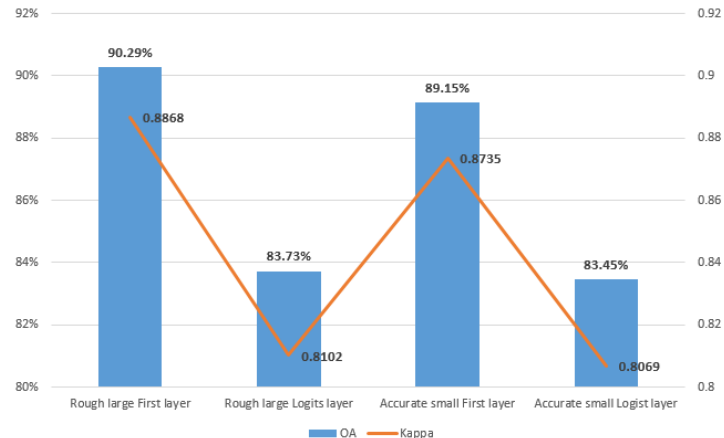
Figure 4. Result of four training strategies (OA: Overall